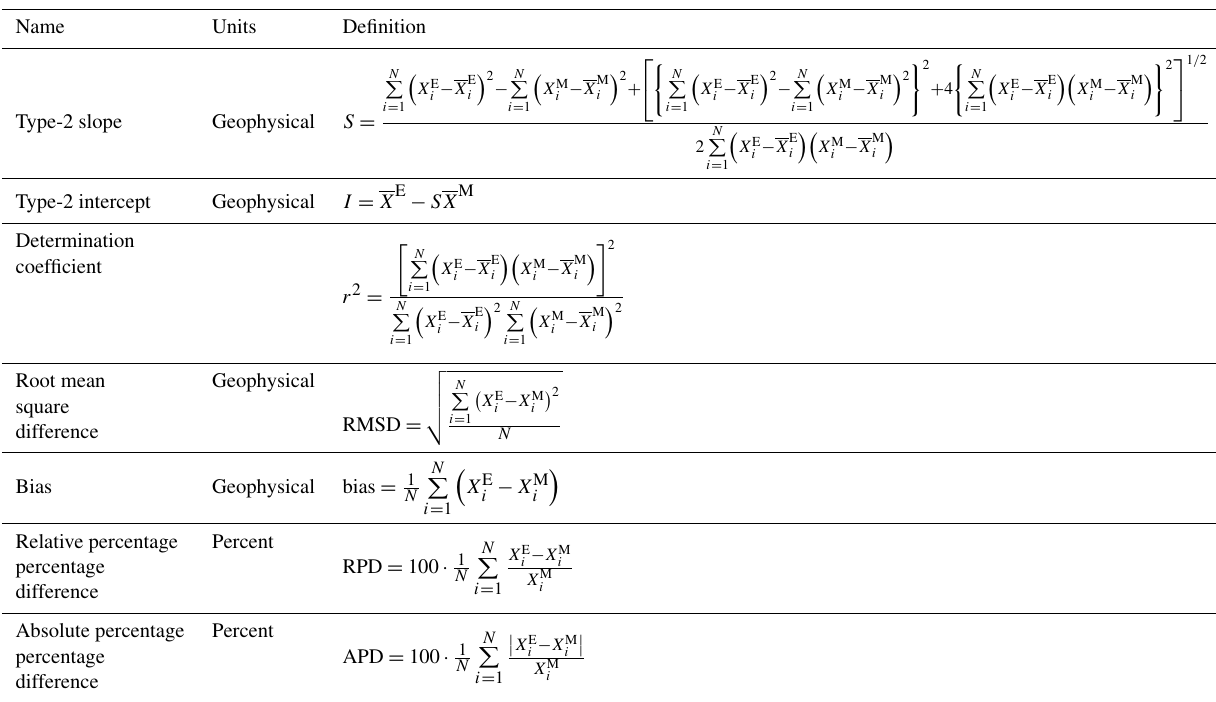
Table 2. Metrics used to compare the estimated (satellite-based) dataset X E to a reference (measured in situ) dataset X M . A more compre- hensive table of metrics is provided in the Supplement (Table S1). In the units column, G stands for geophysical and refers to sr − 1 , m − 1 , or mgm − 3 when the statistics are associated with Rrs, Kd, or Chl, respectively.